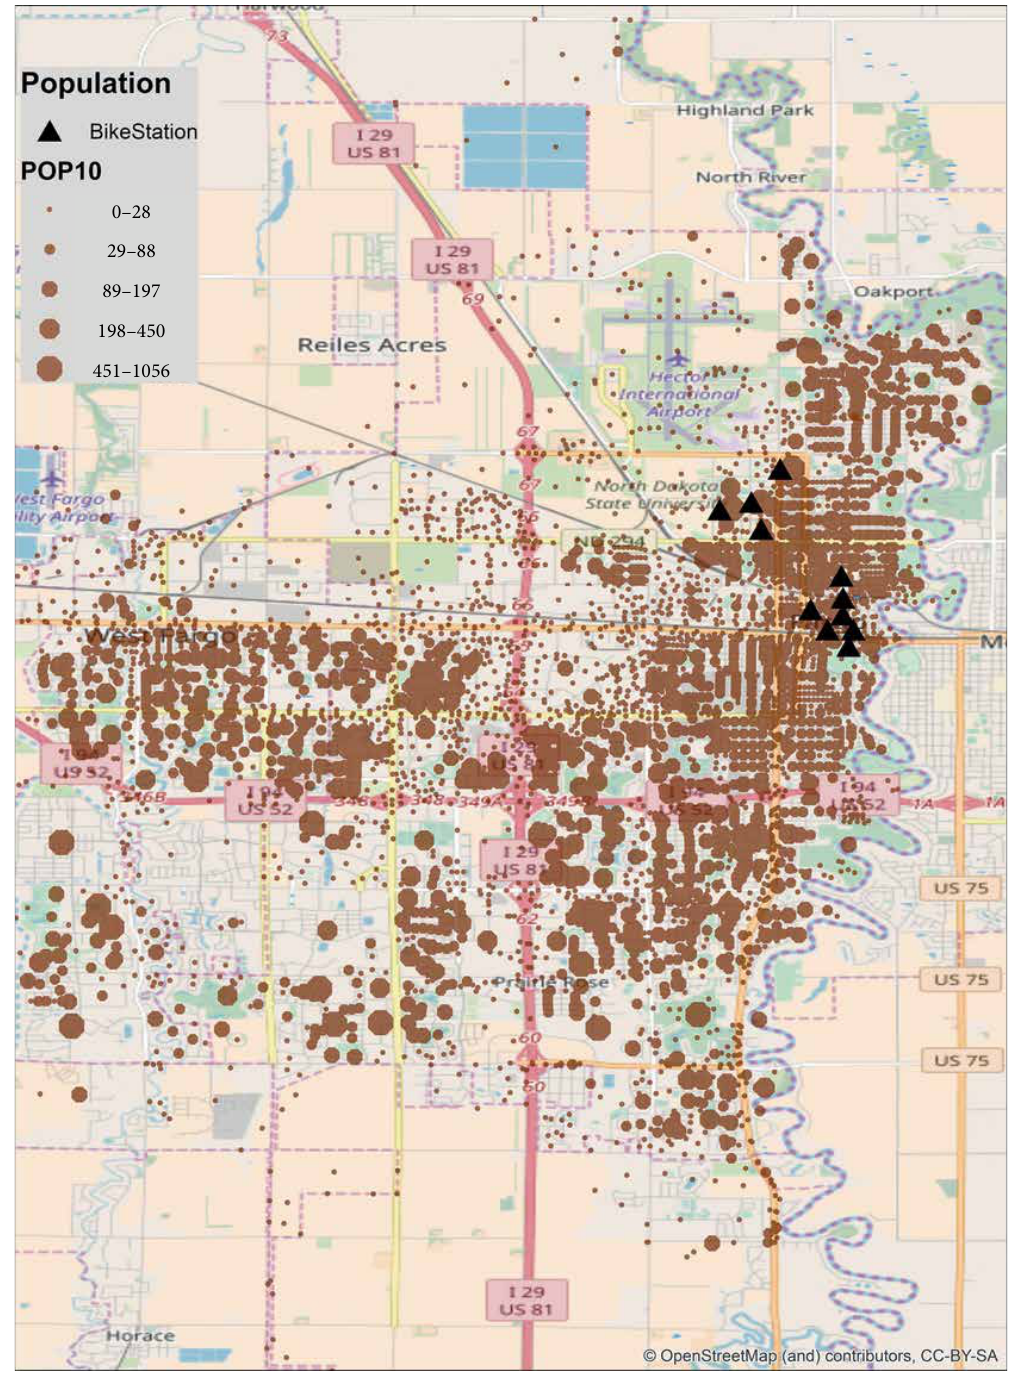
Figure 5: The geography, transportation network, and population of Fargo, ND . The locations of the existing eleven bike stations in Fargo are shown with a triangle in the